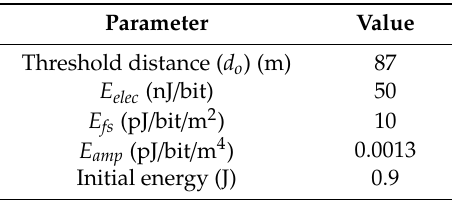
Table 2. Network